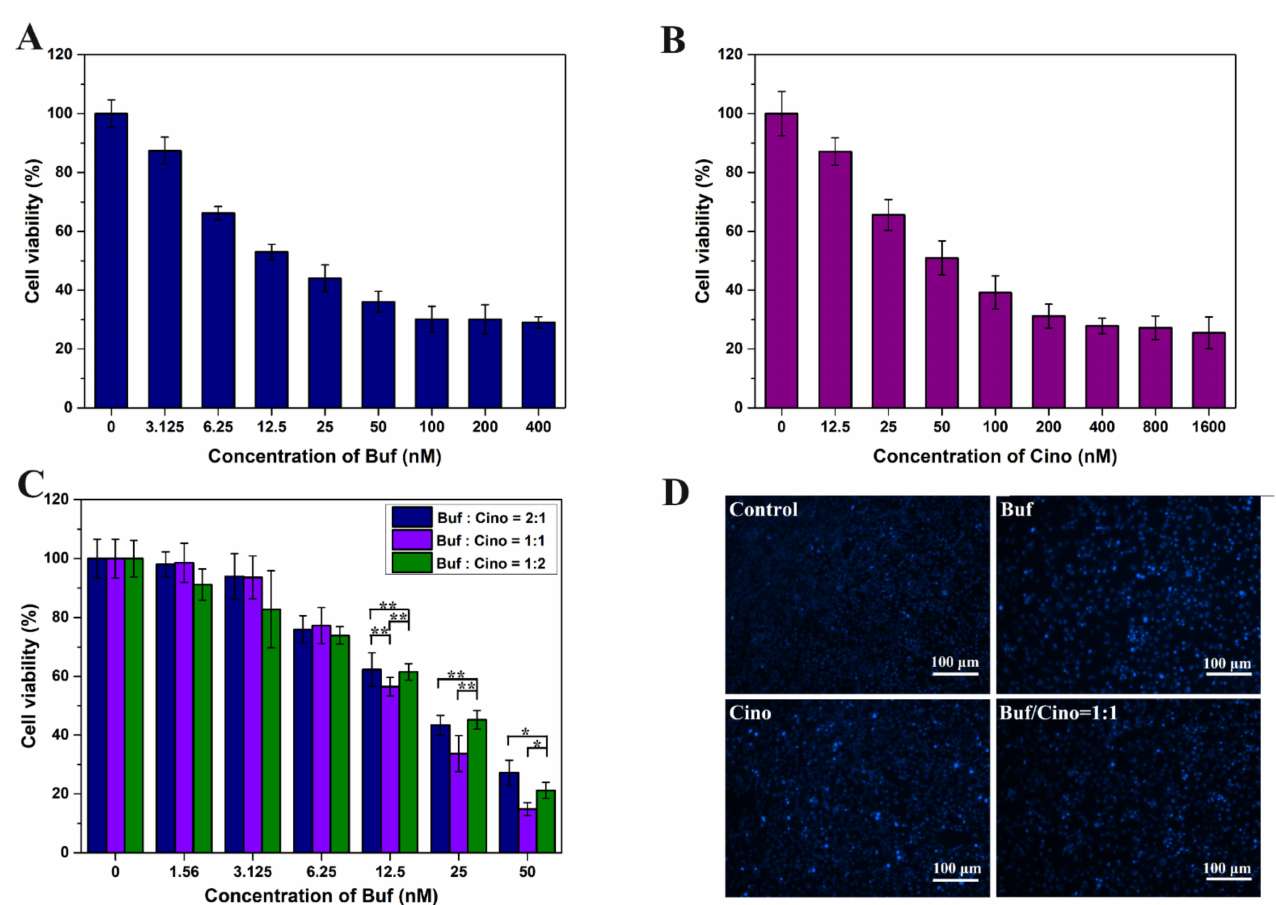
Figure 3. The HepG2 cells viability were cultured in different concentrations of drugs for 24 h. ( A ) Buf, ( B ) Cino, ( C ) used in combination. ( D ) Hoechst 33342 staining was performed by the treatment of Buf, Cino, and the combination, respectively. “*” means p < 0.05, and “**” means p < 0.01 between two